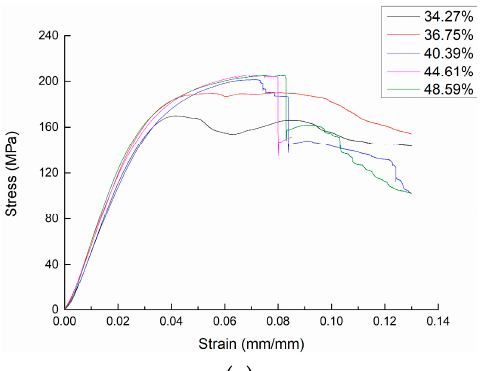
Figure 7. The bending stress-strain curve of 3DDAI Kevlar/EP armor materials with different con- tents of epoxy resin. ( a ) The warp direction. ( b ) The weft direction.